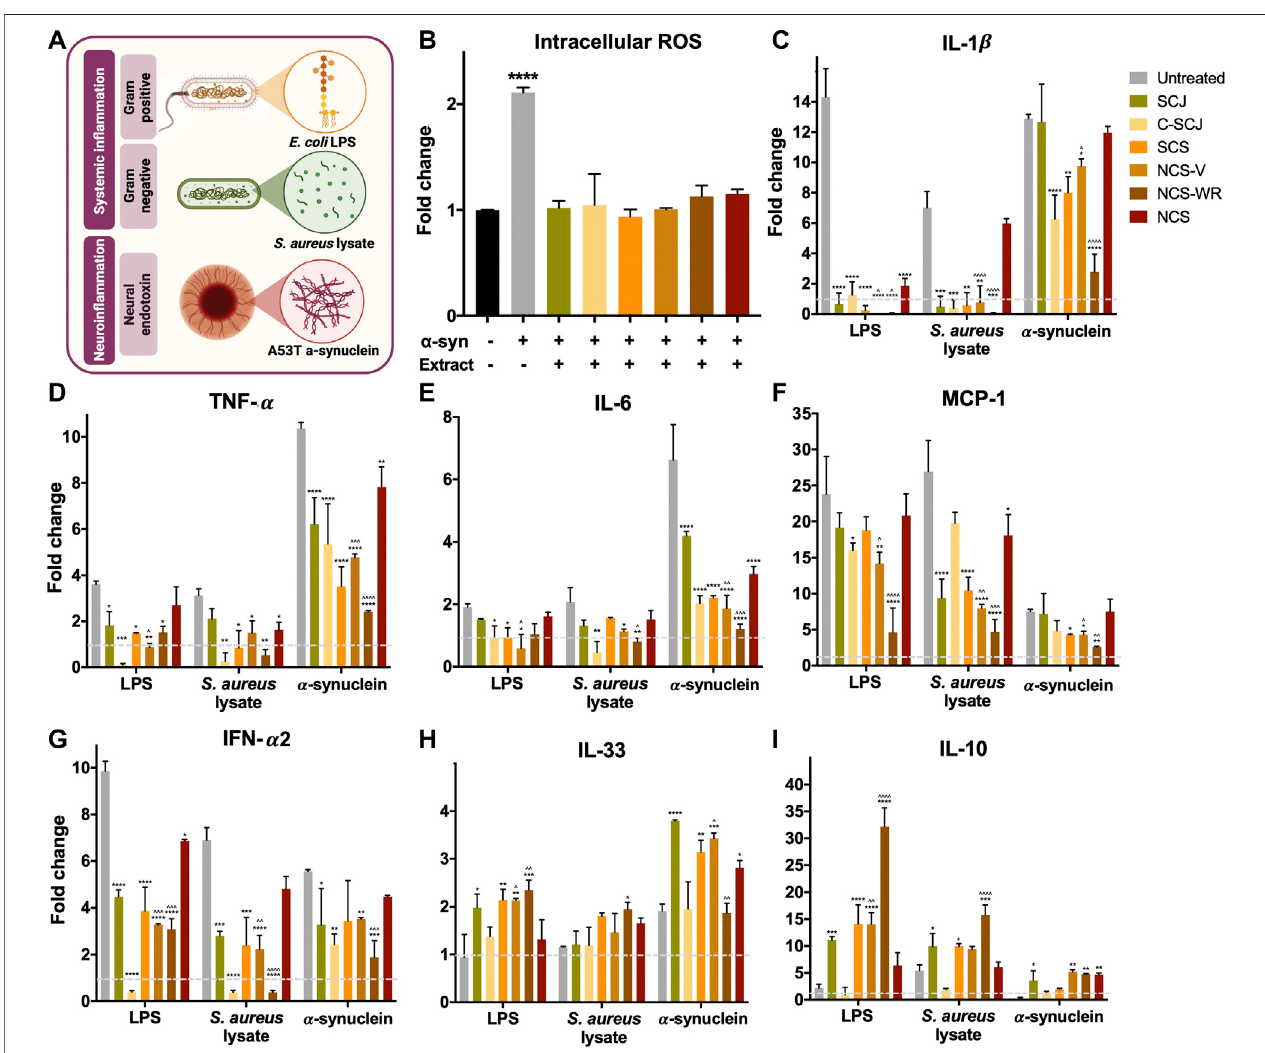
FIGURE 4 | Anti-in fl ammatory effect of sugarcane-derived extracts. (A) Schematic illustration of the three stimulating agents employed for each considered in fl ammation scenario. Namely, LPS and an S. aureus lysate at 5 μ g/ml dosages for modeling systemic in fl ammation through gram positive and negative bacteria in macrophages, and A53T α -synuclein at 10 μ g/ml dosage for modeling neuroin fl ammation in in fi ltrating monocytes. Created with Biorender.com. (B) Intracellular ROS production in α -synuclein stimulated THP-1 monocytes in the presence and absence of sugarcane-derived extracts. All extracts signi fi cantly hamper ROS productioninresponsetoin fl ammatorystimuli.(*)denotesstatisticalsigni fi cancewithrespecttountreatedandunstimulatedcontrol. (C) FoldchangesecretionofIL-1ß, (D) TGF- α , (E) IL-6, (F) MCP-1, (G) IFN- α 2, (H) IL-33 and (I) IL-10 under each in fl ammation scenario in the absence and presence of sugarcane-derived extracts, with respected to unstimulated controls. Red labeled cytokines are pro-in fl ammatory and blue-labeled cytokines are anti-in fl ammatory. All extracts downregulate the secretion of pro-in fl ammatory cytokines and upregulate that of anti-in fl ammatory cytokines, especially modi fi ed NCS extracts. (*) denotes statistical signi fi cance with respect to stimulated but untreated controls, and ( ^ ) denotes signi fi cance with respect to traditional NCS.